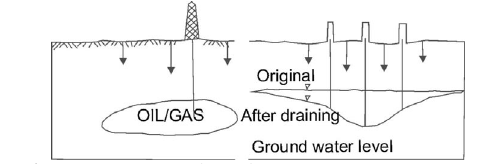
Fig 2. Example of artificial processes causing